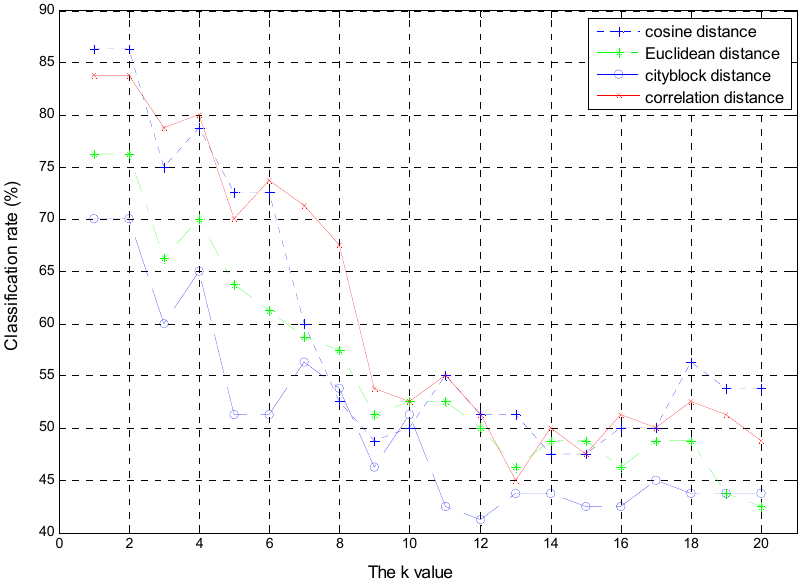
Figure 5. The performance of KNN with different k values and distance metrics. Table 5. Comparison with different optimization methods for